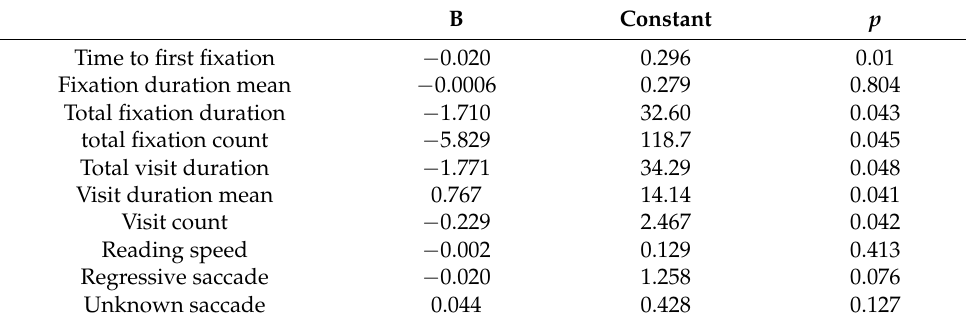
Table 5. Regression analysis of eye movement parameters and